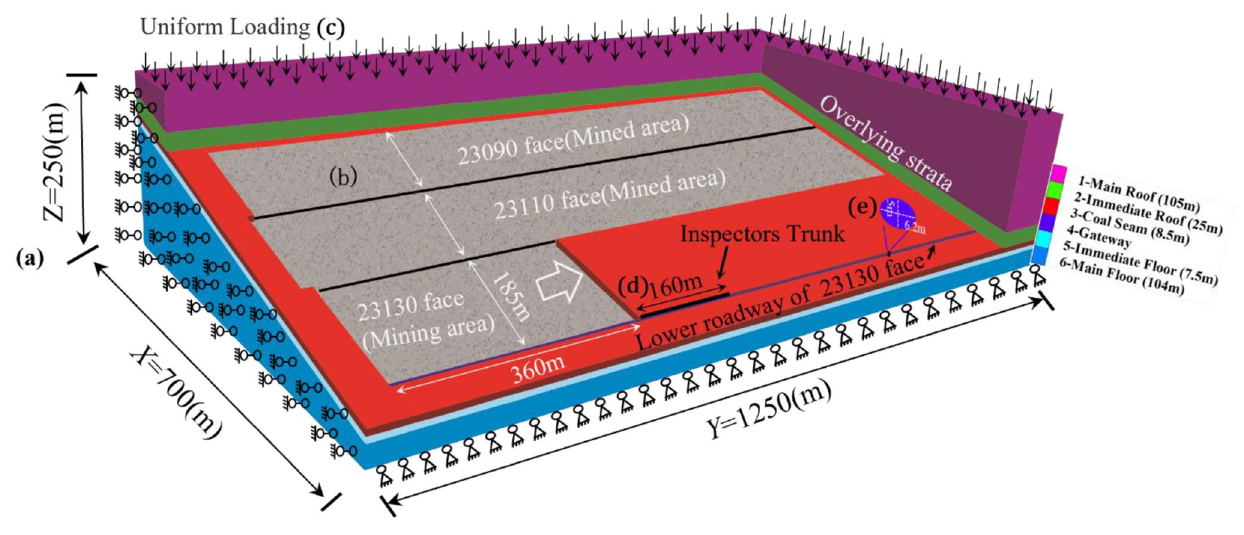
Fig. 5 Three-dimensional numerical analysis model and working surface